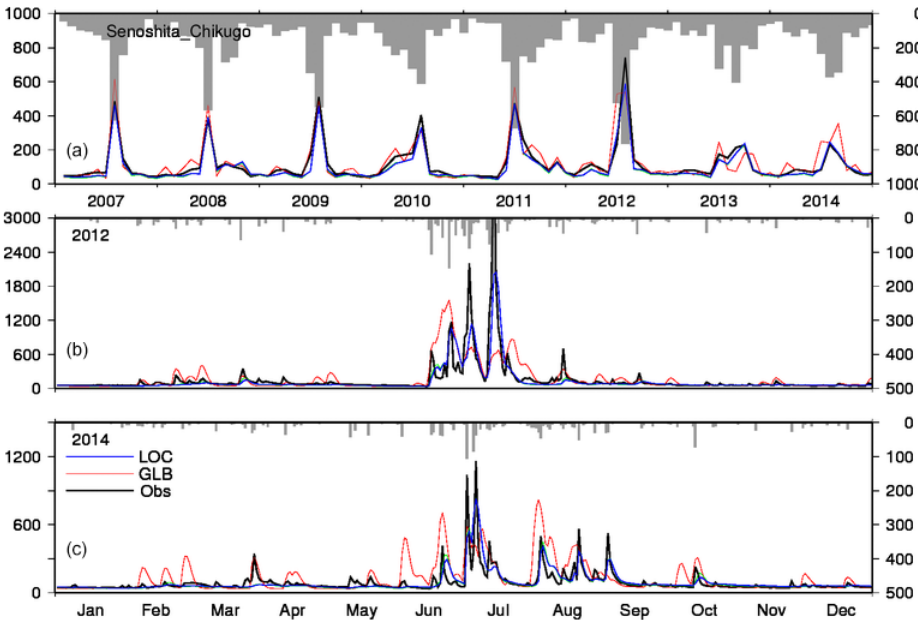
Figure 5. River discharge at Senoshita on the Chikugo River. The unit is cubic meters per second (m 3 s − 1 ). (a) Monthly time series of streamflow (lines) and basin-averaged precipitation in the LOC simulation (bars). (b) Daily time series of streamflow and precipitation in the wettest year of the validation period. (c) Daily time series of streamflow and precipitation in the driest year of the validation